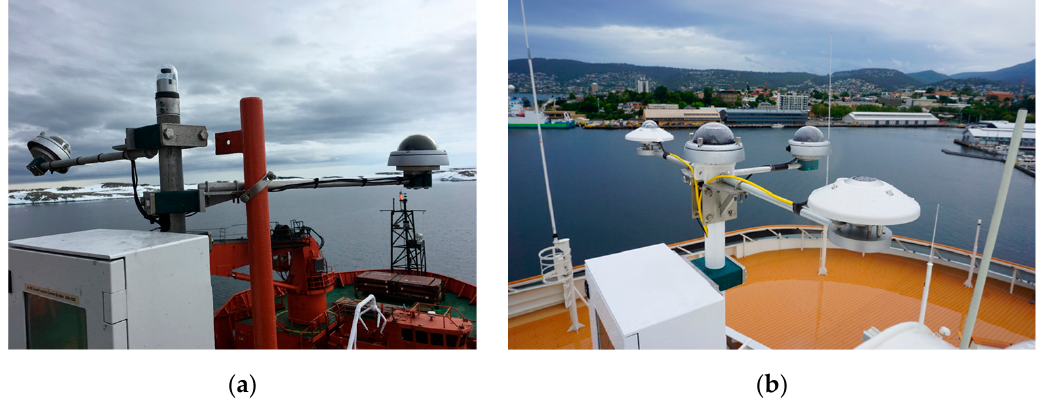
Figure 2. ( a ) Instrumentation on the “monkey island” of the RSV Aurora Australis during the 2018 to 19 season. The all-sky camera was mounted on the top of the mast. A forward-facing wide-angle camera on the port (left) side was used to provide additional information on surface conditions. An upward-looking wide-angle sky-viewing camera on the starboard (right) side was not used in the analysis presented here. ( b ) Instrumentation on the upper superstructure of MS The World. The wide-angle camera is mounted in the centre of the mast. A second sky-viewing camera with a narrower field-of-view was mounted towards the bow (front) of the ship but was not used for the analysis presented here. The pyranometer is mounted on the arm to the left (toward the port side of the ship), and the pyrgeometer is on the arm to the right (toward the starboard side of the ship).